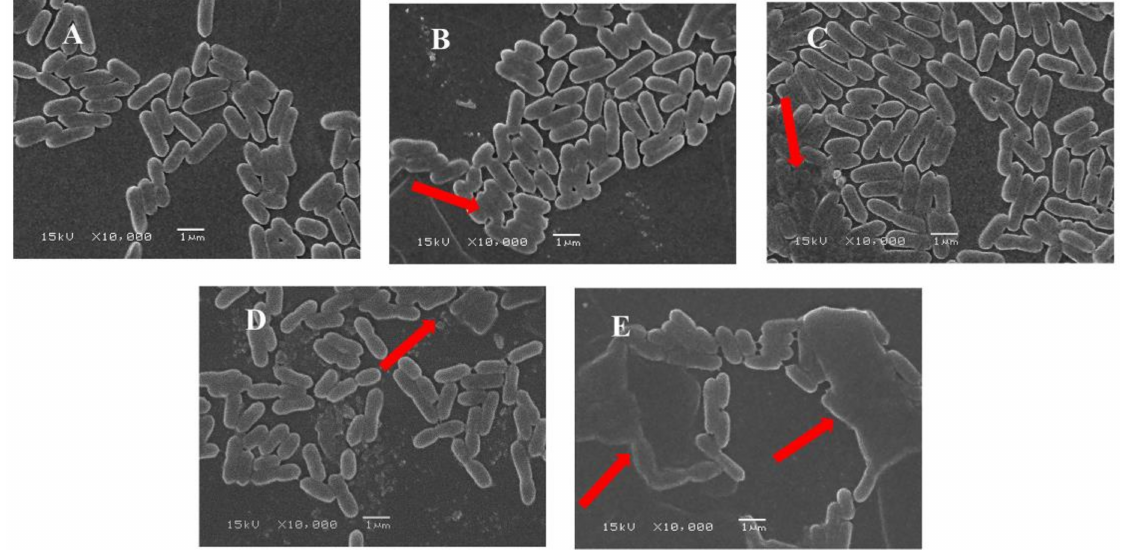
Figure 4. SEM images of Listeria monocytogenes. ( A ) Control group without treatment; ( B ) Curcumin- treated group; ( C ) Light-illuminated group; ( D ) Ultrasound-treated group; ( E ) SPDT: Curcumin- mediated sono-photodynamic treated